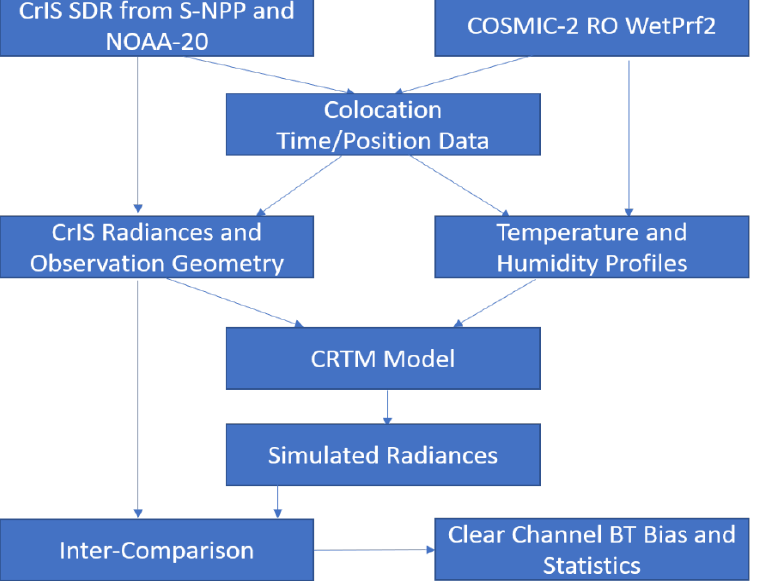
Figure 3. Flow chart for CrIS SDR and COSMIC-2 RO data matchup for radiance simulation and inter-comparison. The matchup criteria are time less than 30 min, a distance less than 50 km, and over the ocean.